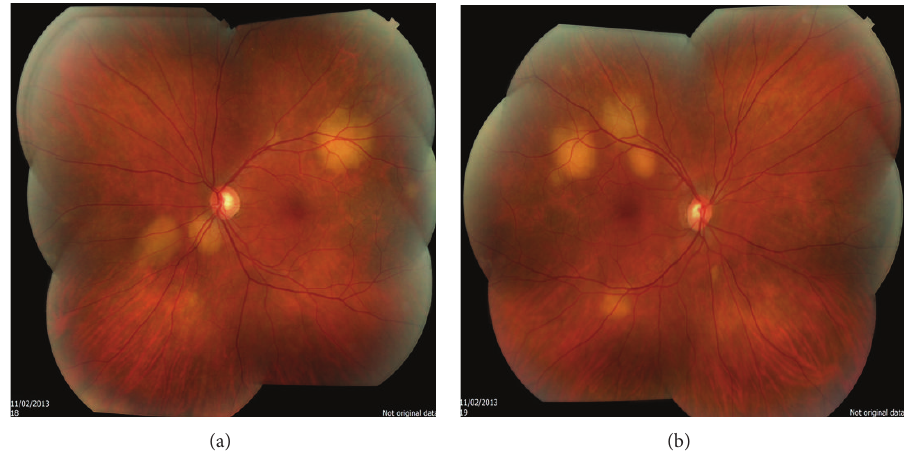
Figure 3: A fundoscopic examination revealed the presence of multiple choroidal masses in both